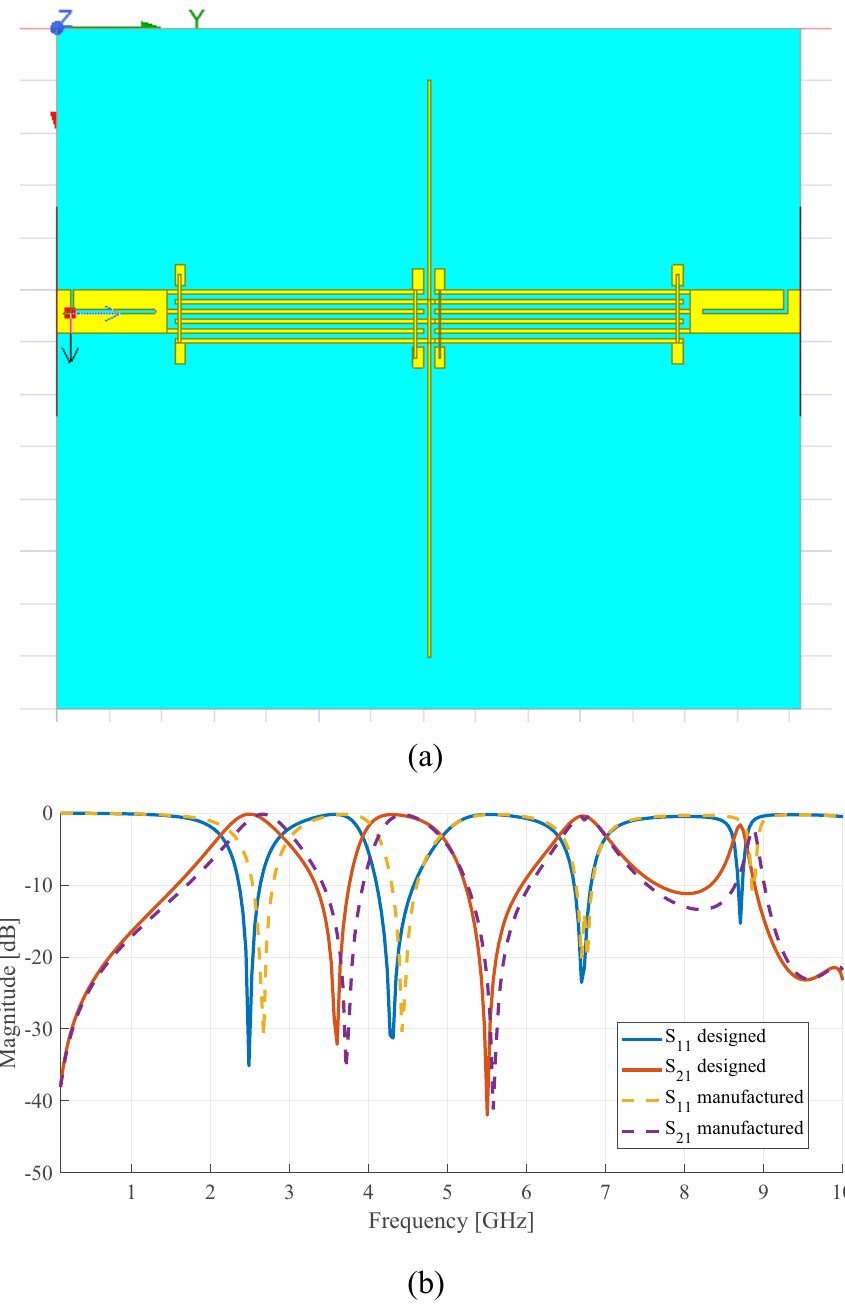
Figure 5. ( a ) Photograph of the simulated filter ( b ) simulated scattering matrix elements ( S 11 and S 21 ) of the designed and manufactured prototype. Table 2. Comparison among the proposed multiband filters and published